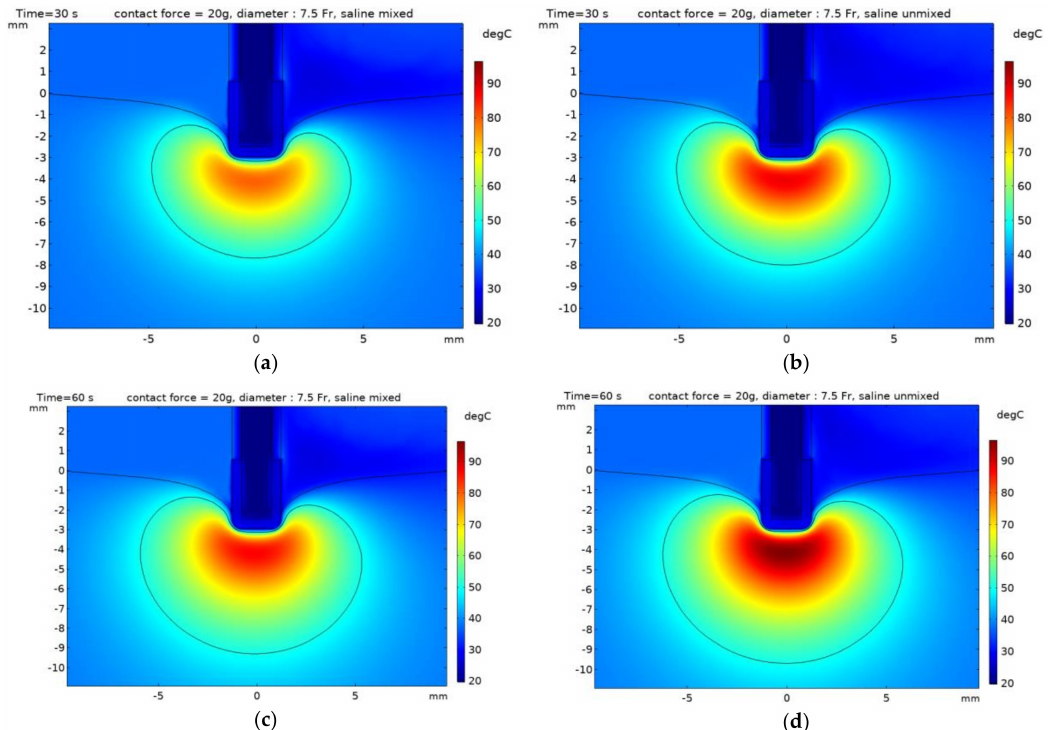
Figure 10. Temperature distribution with contour 50 ◦ C of the heart tissue with the catheter diameter of 7.5 Fr and contact force of 20 g. ( a , b ) time: 30 s, ( c , d ) time: 60 s, ( a , c ) model mixed saline, ( b , d ) model